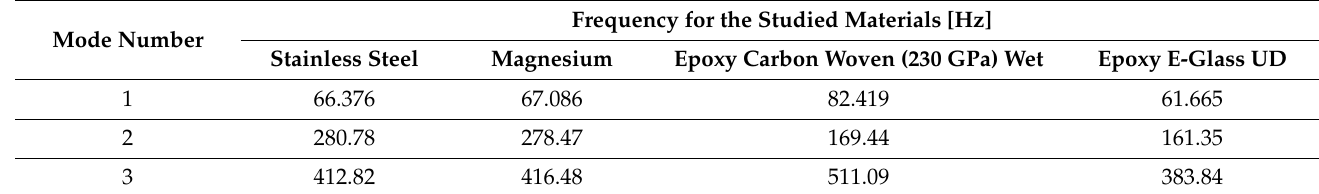
Table 1. Results of ANSYS modal analysis for the studied